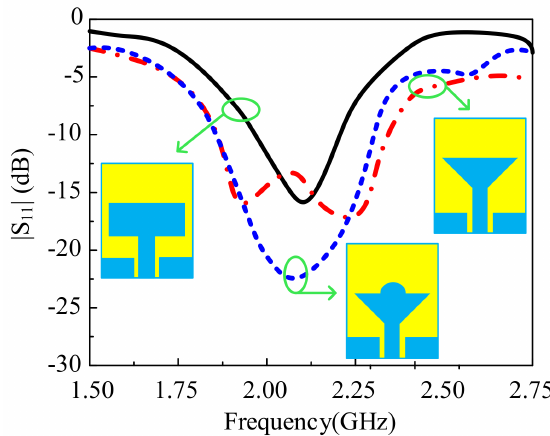
Figure 2. Extraction of the wideband antenna from conventional